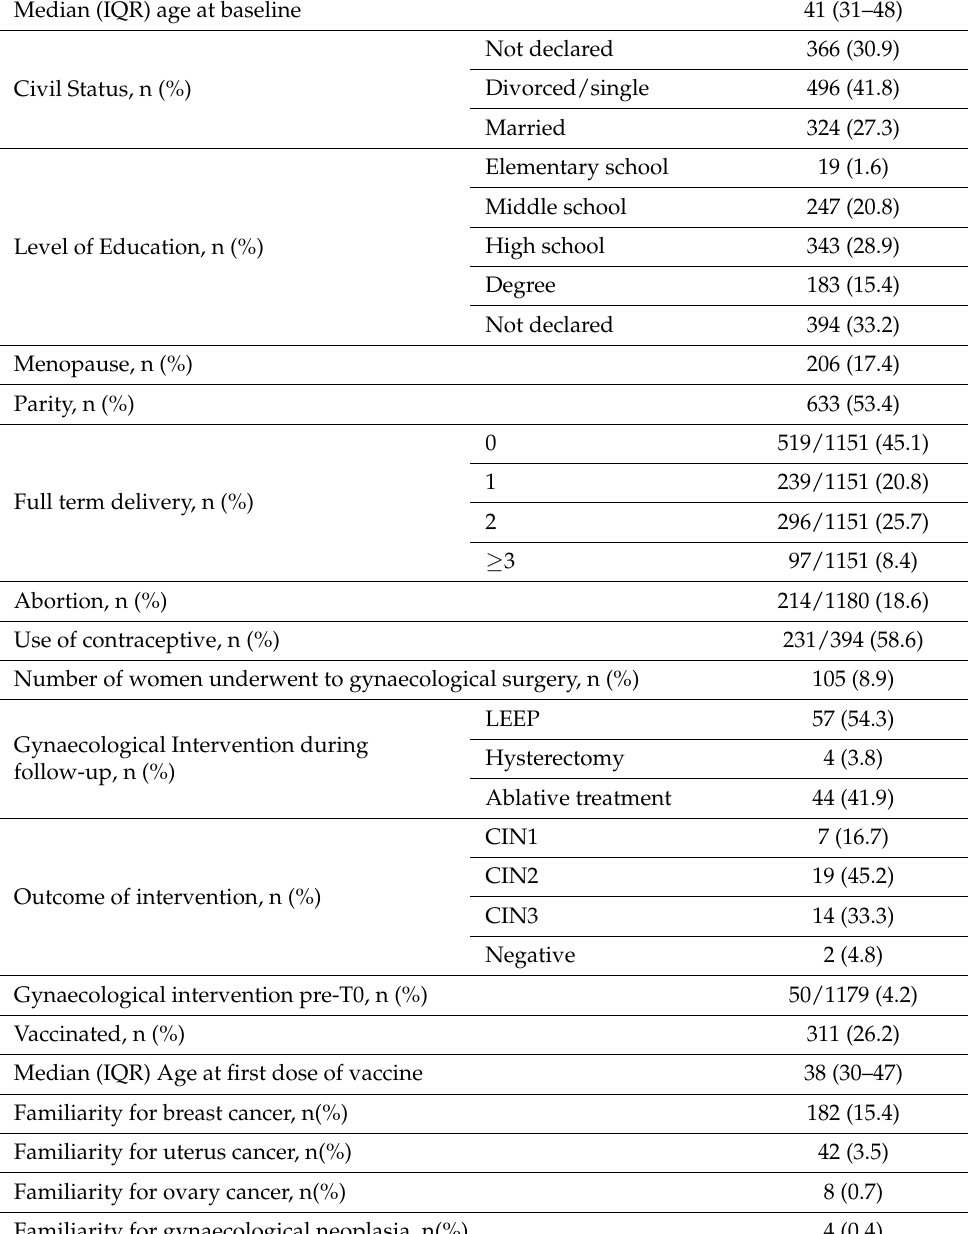
Table 1. Demographic characteristics of the cohort